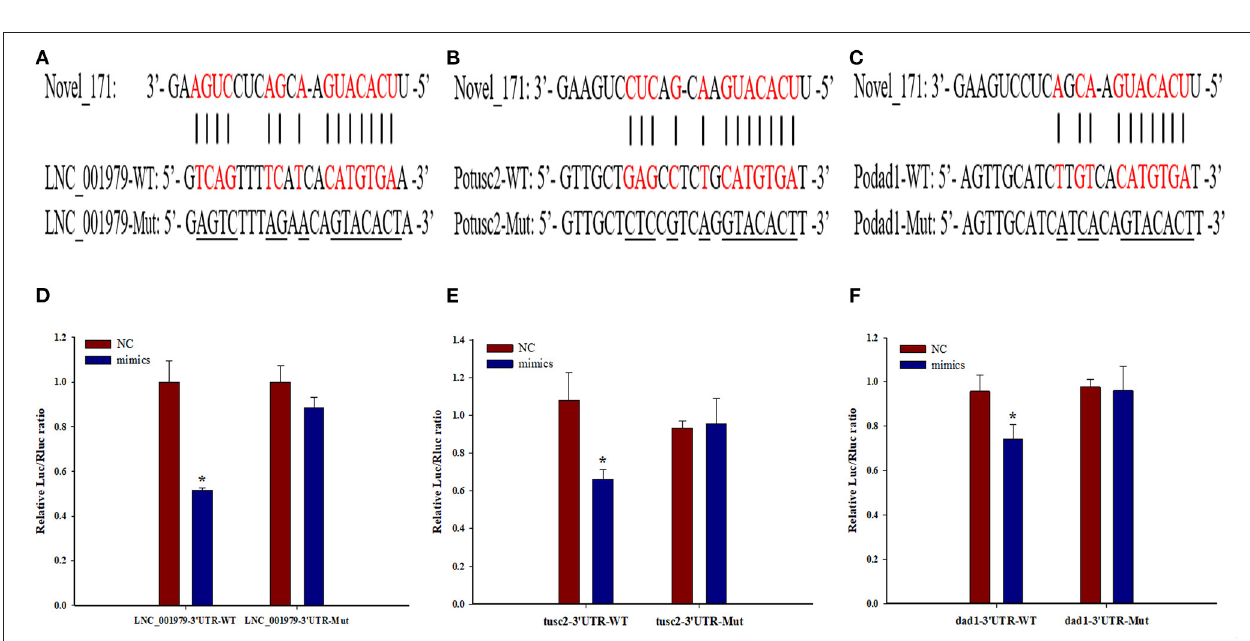
transcriptional, and post-transcriptional levels (32). In